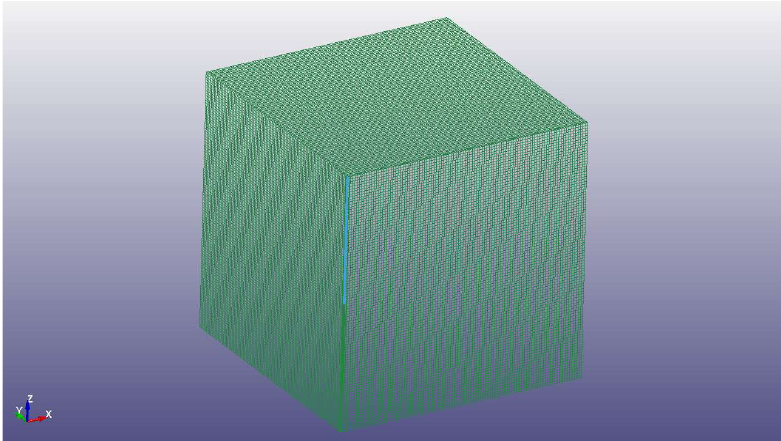
Figure 2. Single-column explosives blasting damage test model. Table 1. Parameters of custom constitutive